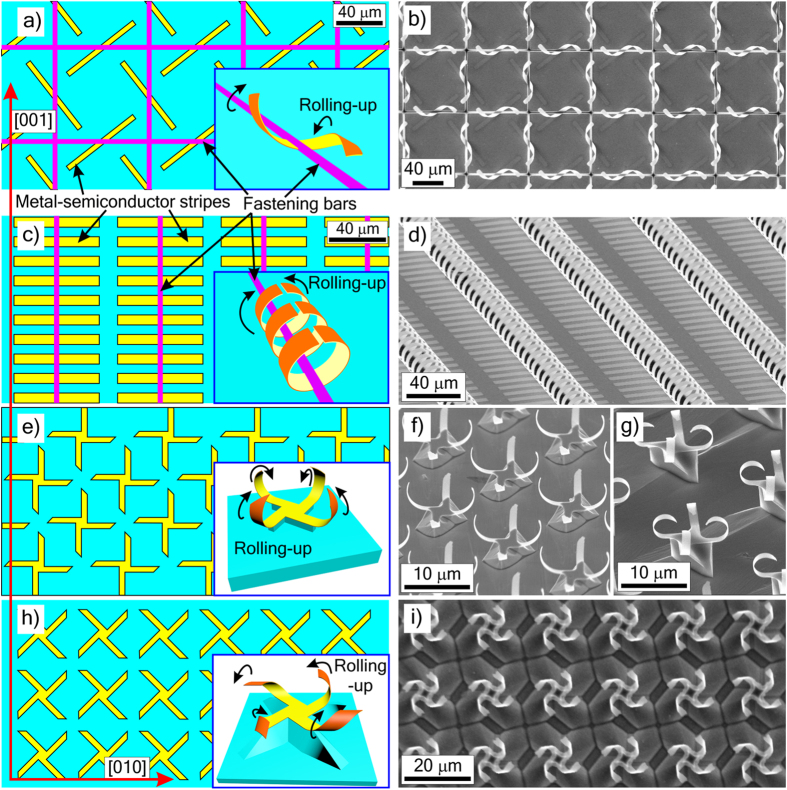
Approach 2: Directional rolling of separate elements.Schematics of lithographic arrays of strained heterofilm strips (a,c) and the transformation of the strips into helices (a, inset) and rings (c, inset) depending on the rolling direction. SEM-images of fabricated metamaterial configurations: square grid of helices (b) and parallel rows of up-right split rings (d). Helices are made of In0.2Ga0.8As/GaAs/Ti/Au (16/41/3.5/65 nm) film, rings are made of In0.15Ga0.85As/GaAs (20/95 nm) film. Schematics of the initial arrays of strained heterofilm crosses differently oriented on the substrate (e,h), transformation of a cross into a crossed split-ring element (e, inset) and into a propeller-like chiral element (h, inset). SEM-images of arrays: (f) crossed half-rings (In0,6GaAs0,4/In0,4GaAs0,6, 50/50 nm), (g) crossed split rings (In0,47Ga0,53As/In0,64Ga0,36As, 25/25 nm) on InP substrate; (i) chiral propeller-like elements (Si0.65Ge0.35/Si0.85Ge0.15, 16/8 nm) on Si substrate, the elements are suspended on the stems etched from the substrates. Strained film elements are yellow (top layer) and orange (bottom layer), resist is magenta, and substrate is cyan. All the initial lithographic patterns (a,c,e,h) are drawn with horizontal orientation of [010] and vertical orientation of [001] crystallographic directions (red arrows), which correspond to the energy-optimal rolling-up.